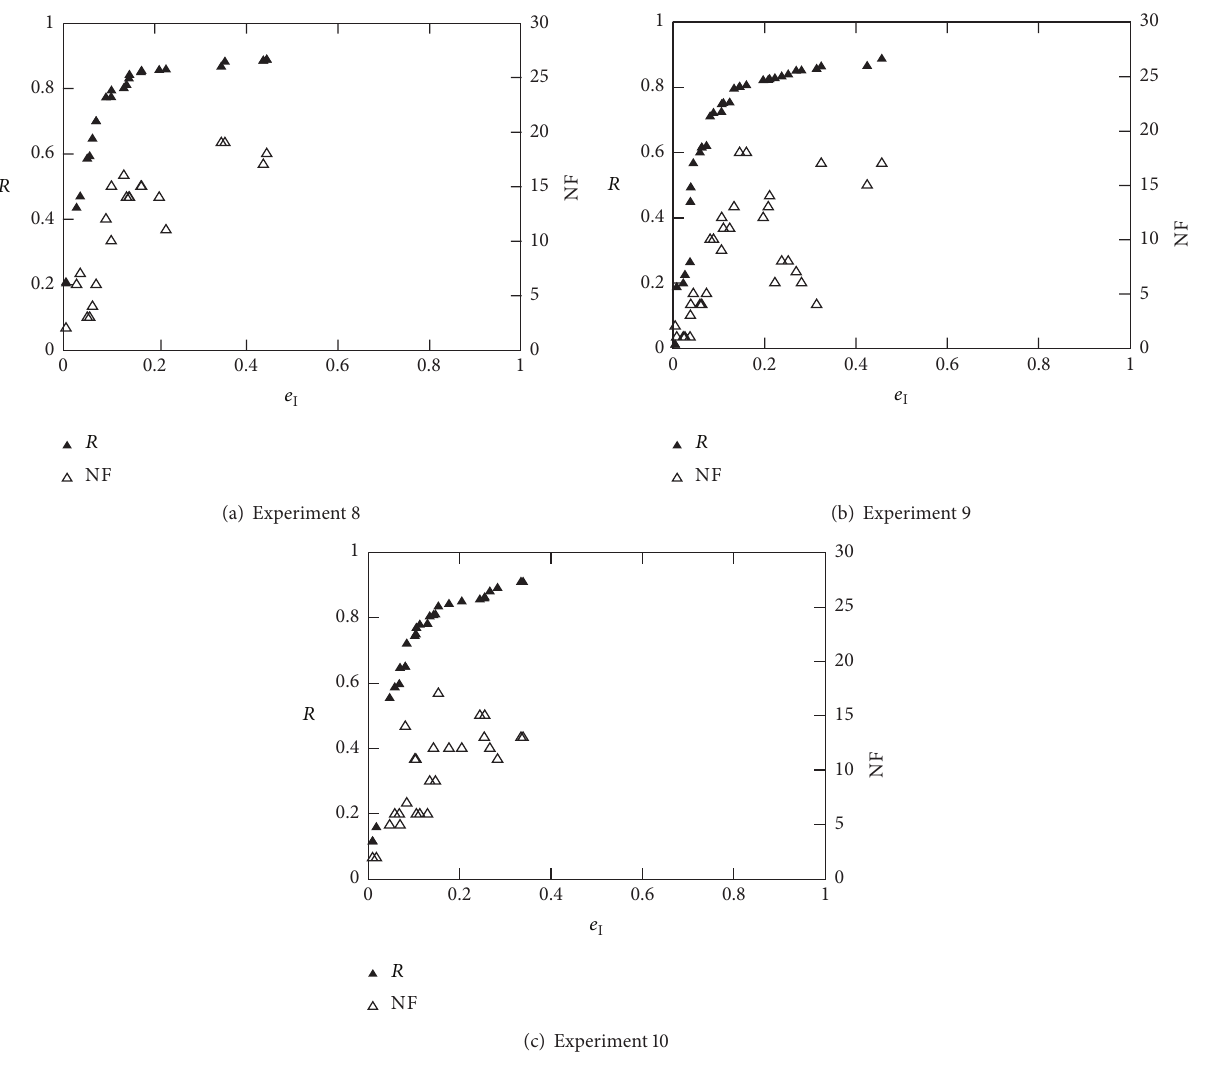
Figure 11: ROC curves for Diane 05 data (best of 10